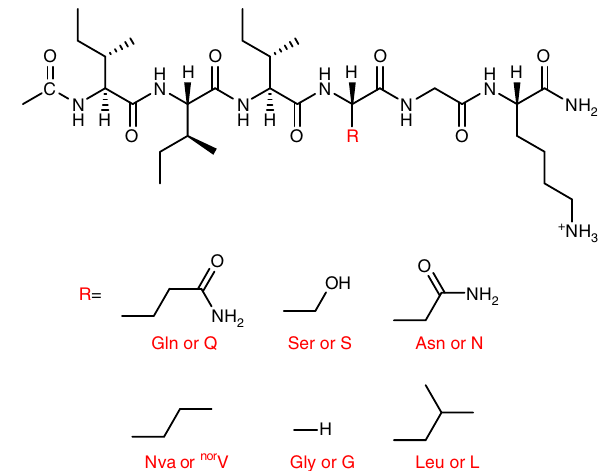
Fig. 1 The general molecular structure of the designed short peptides Ac- I 3 XGK-NH 2 . Indicative side chain substitutions are marked by R. X is Q, S, N, nor V, G, and